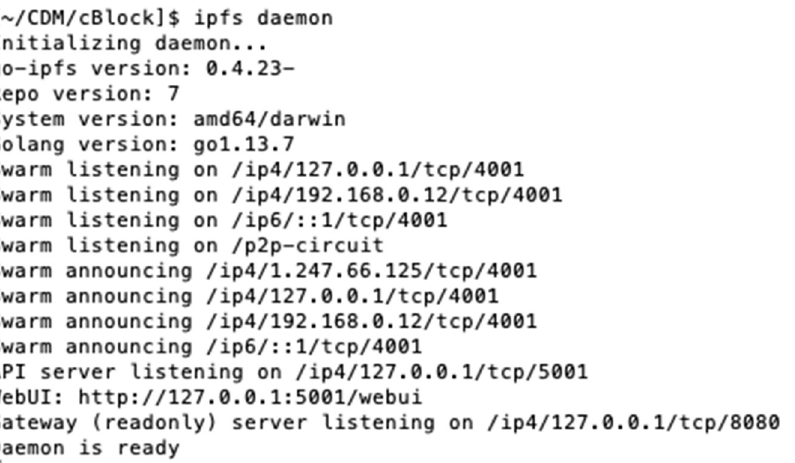
Figure 6. Starting the Inter Planetary File System (IPFS) as daemon.